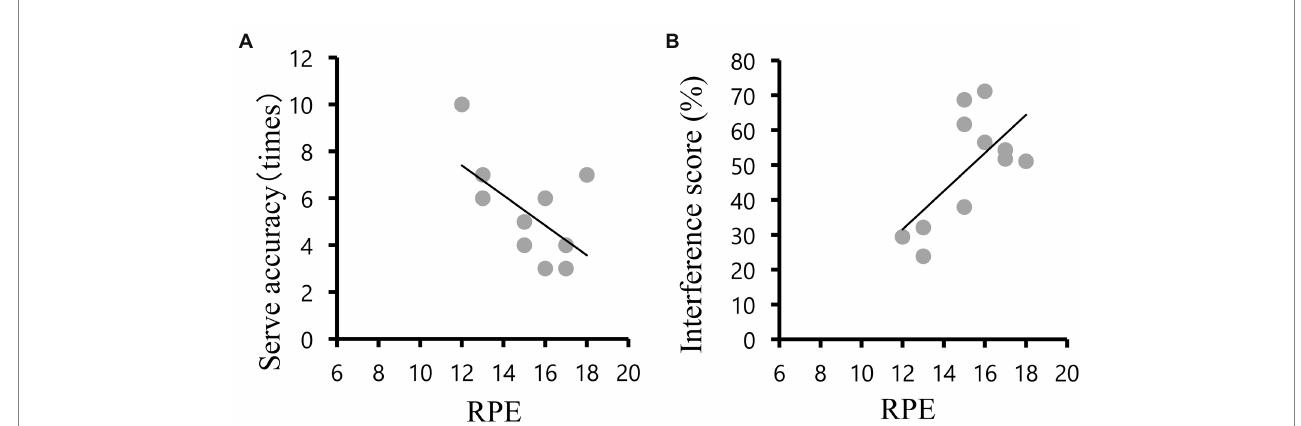
FIGURE 2 (A) An inverse correlation was detected between post-exercise serve accuracy and post-exercise rating of perceived exertion ( r = − 0.57, p = 0.07). (B) A correlation was detected between post-exercise reaction time in the Stroop Color and Word Test and post-exercise rating of perceived exertion ( r = 0.65, p = 0.03).